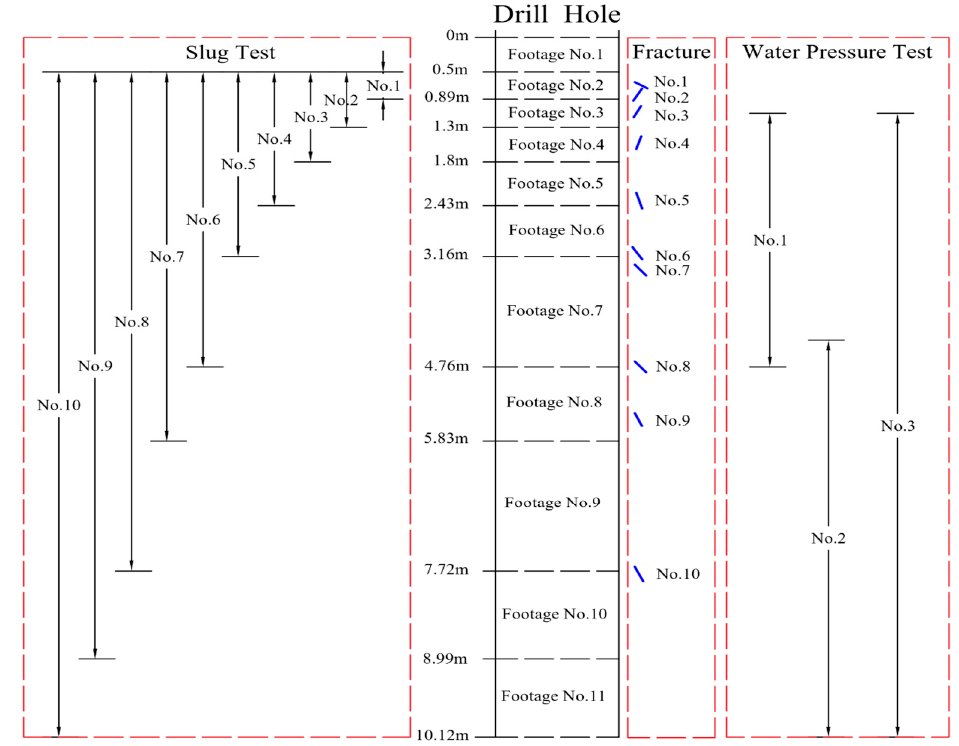
Figure 6. Test section of slug tests and water pressure tests.